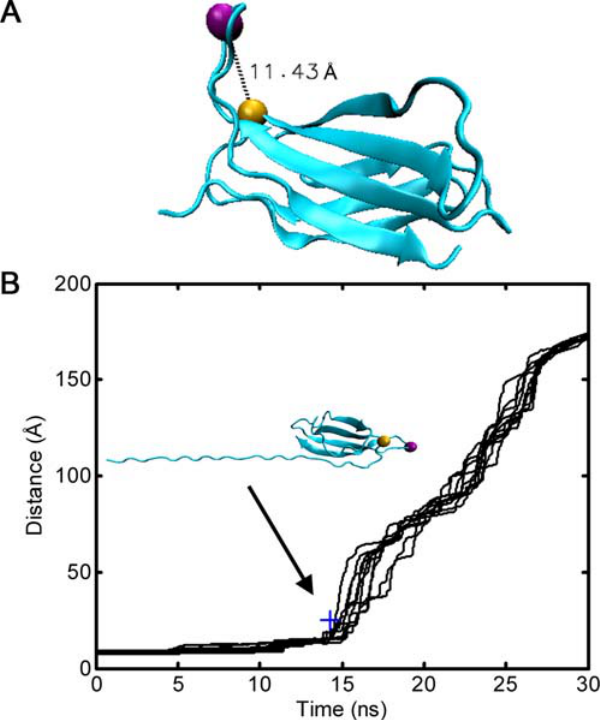
Figure 6. The Arginine Cell Detachment Trigger. (A) R1445 in the crystal structure of 10FNIII. Residues R1445 and G1494 (the central glycine in the RGD motif) are depicted as gold and magenta spheres, respectively. (B) Positioning of an essential arginine during the course of N-to-RGD unfolding. The distance between the C a atoms of R1445 and G1494 is shown as a function of time for each of the ten unfolding simulations along the N-to-RGD axis. R1445 rapidly moves far from the RGD loop once the kinetic intermediate is formed (time point labeled with structure inset).